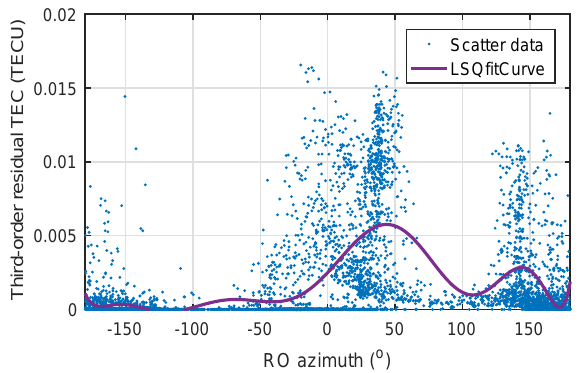
Figure 10. The relationship between third-order ionospheric resid- ual electron density and RO